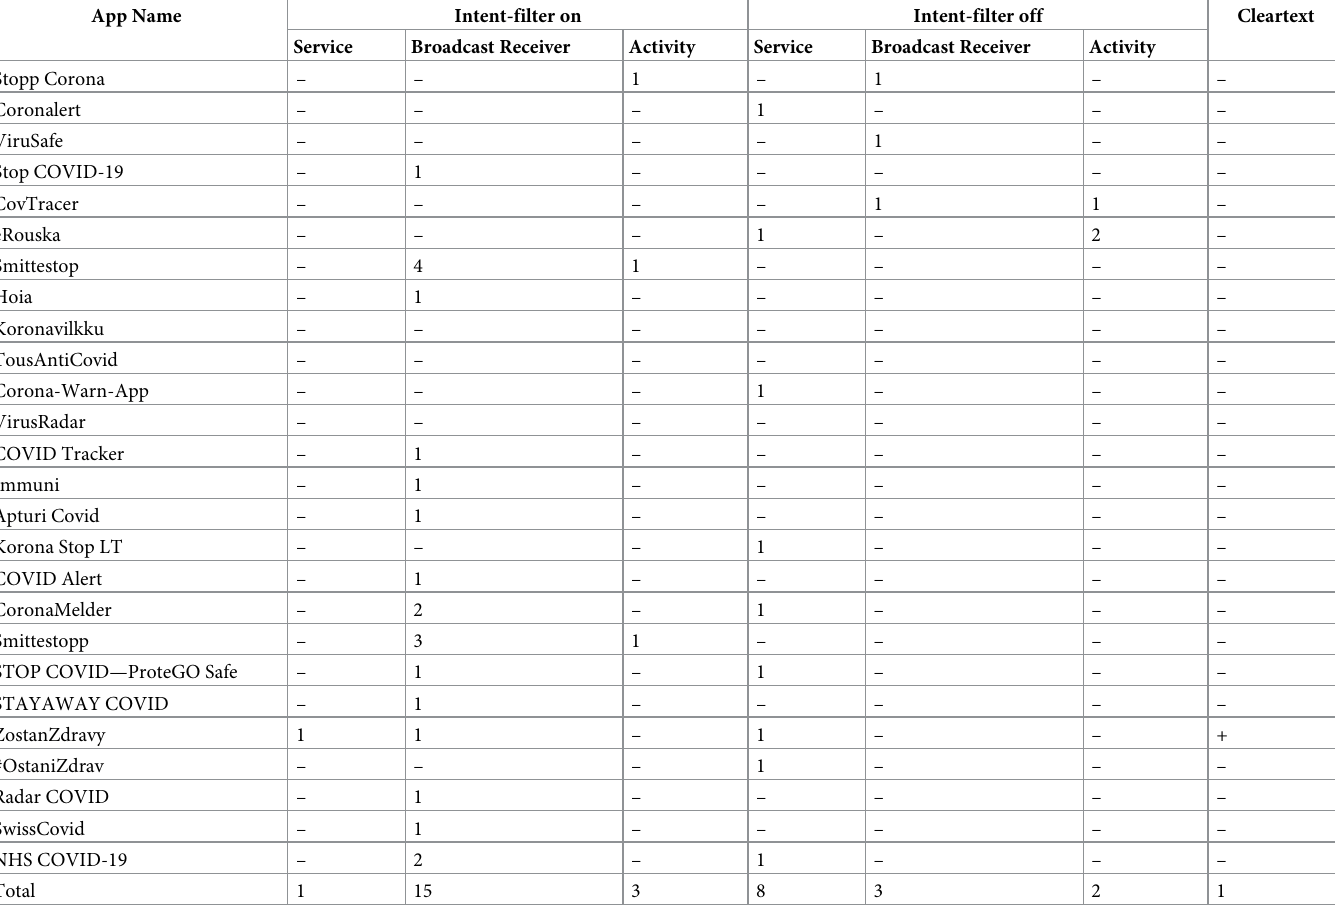
Table 7. Potentially vulnerable components in the manifest file of each